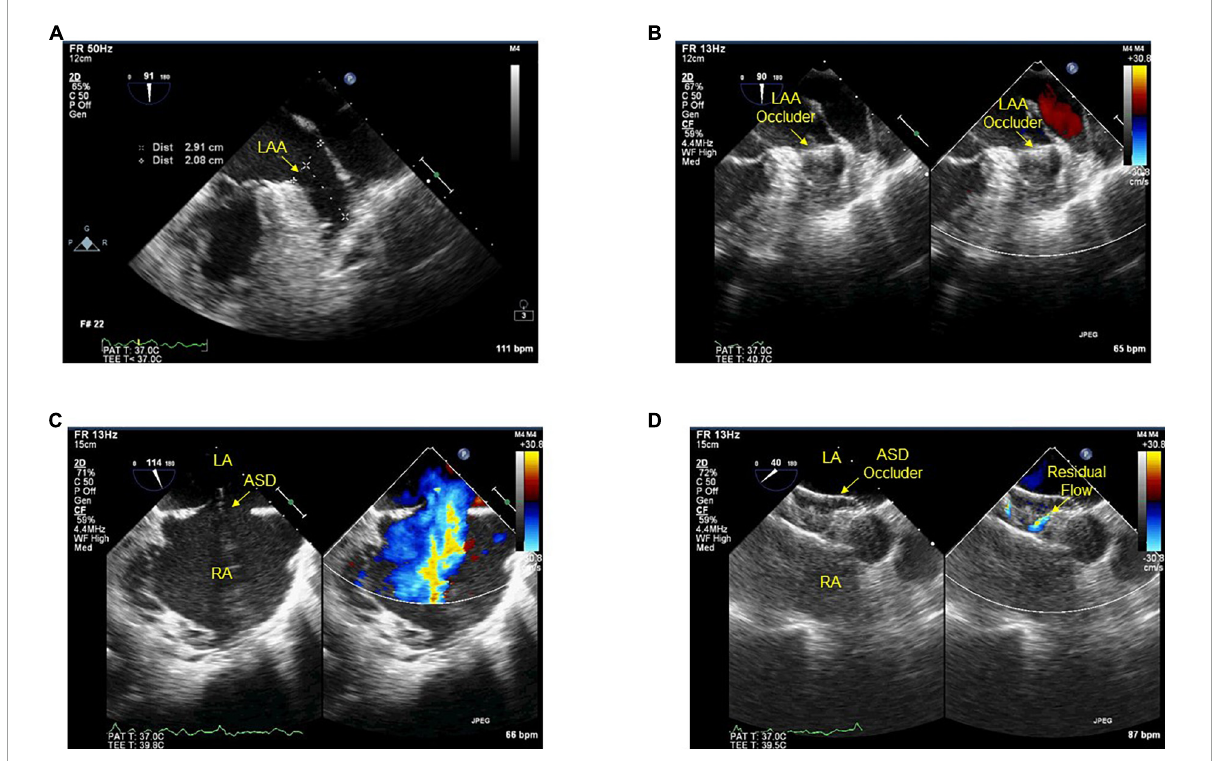
FIGURE3 (A–D) Transesophageal echocardiography during procedures. Before (A) and after (B) the device implanted into the ostium of LAA. Before (C) and after (D) ASD closed with the device, residual flow ≤ 2 mm around the device after implantation. LAA, left atrial appendage; ASD, atrial septal defect; LA, left atrium; RA, right